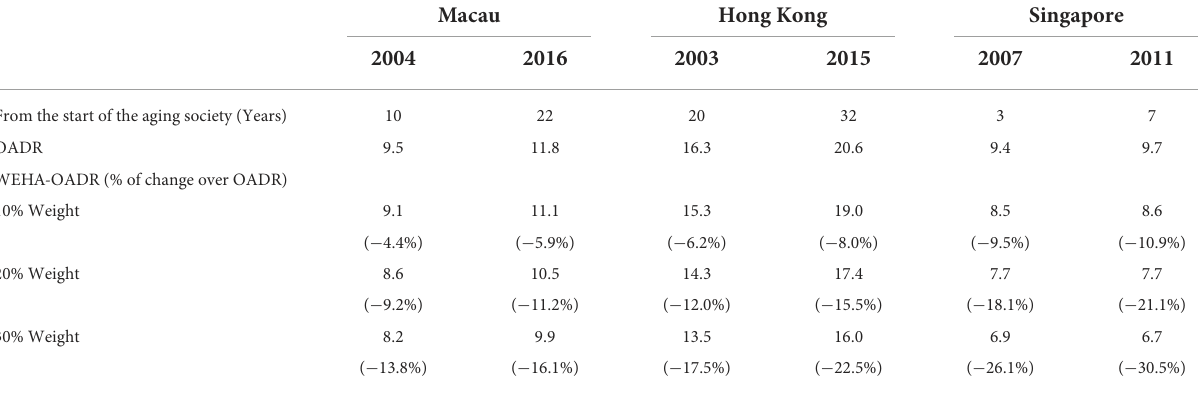
TABLE 3 The comparison of OADR and WEHA-OADR for Macau, Hong Kong, and Singapore. Macau Hong